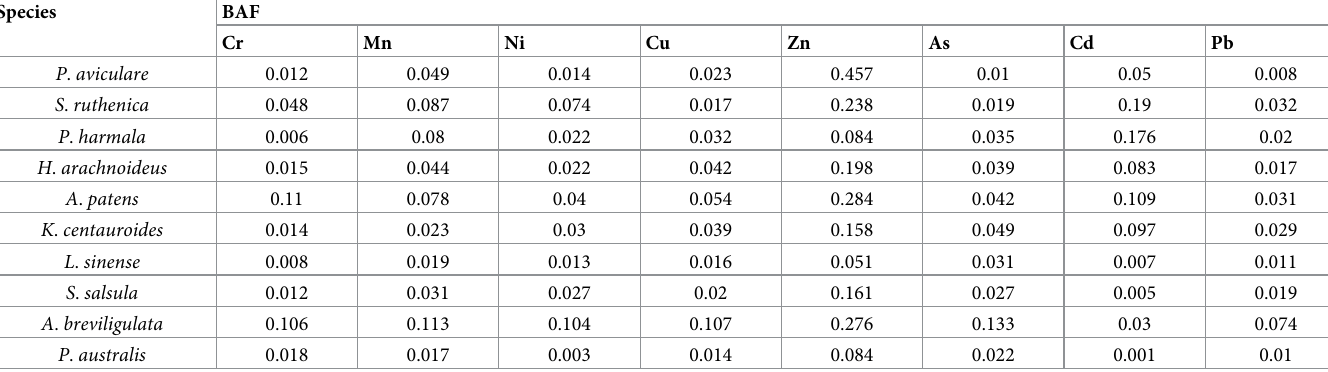
Table 3. Biological accumulation factors (BAF ) for native plants around the tailings pond. Species